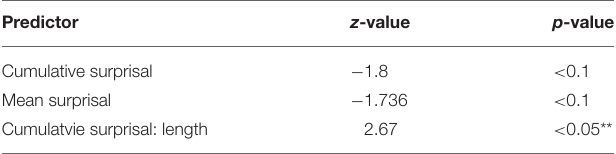
TABLE 8 | Most influential effects in the final GLM predicting position, 1800–1850. Predictor z -value p -value Cumulative surprisal